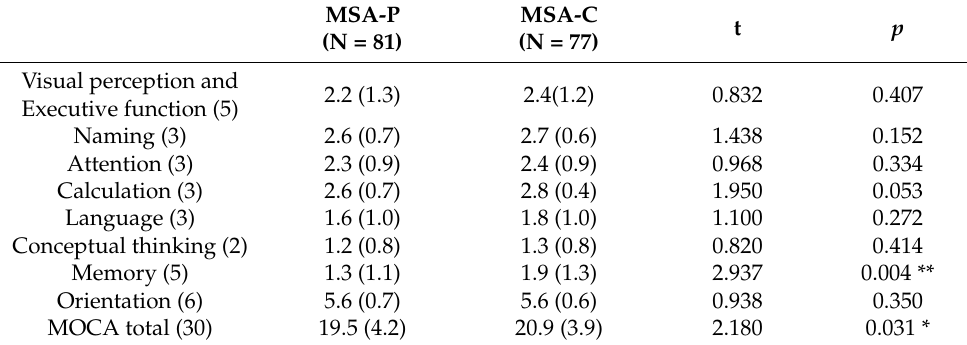
Table 5. Cognitive profiles in MSA-P and MSA-C patients on the